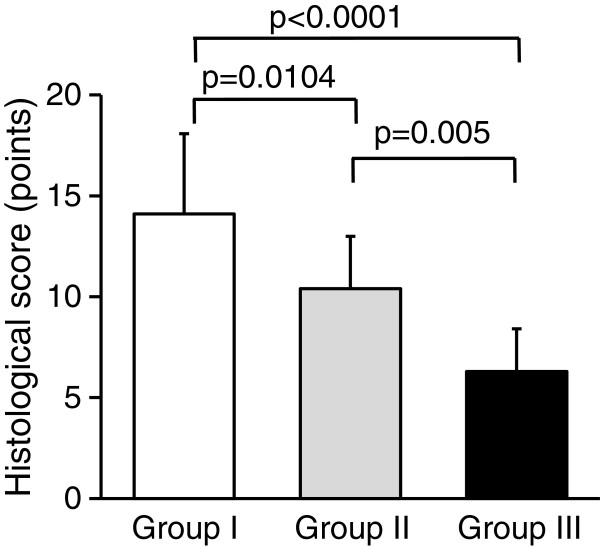
The histological scores at 12 weeks. The ANOVA showed a significant difference among the 3 groups (p < 0.0001). The post-hoc test indicated that Group I was significantly greater than Groups II and III, while Group II was significantly greater than Group III.